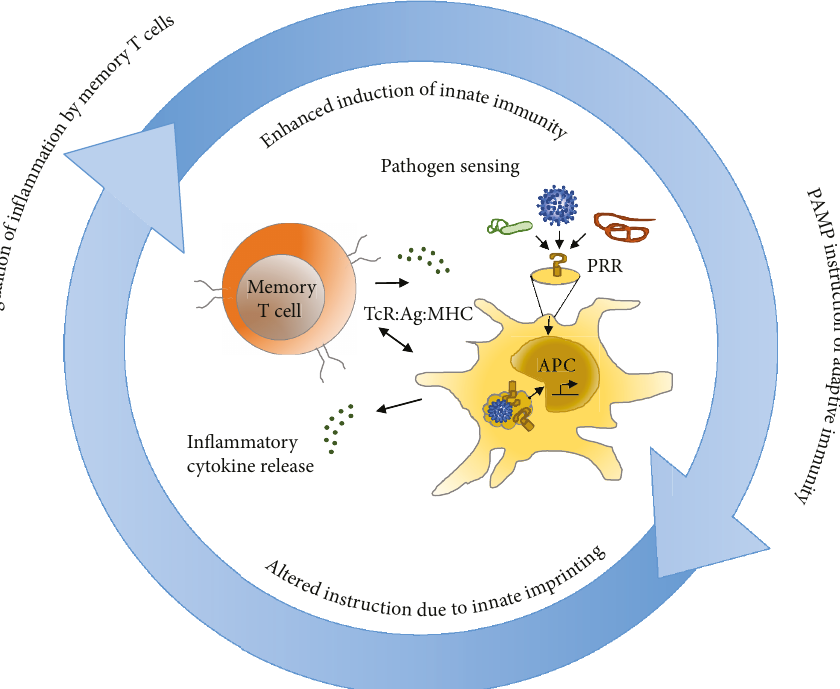
Figure 1: Memory T cells regulate in fl ammation at sites of infection. Traditional paradigms of innate instruction of adaptive immunity must now also appreciate that adaptive memory T cells regulate both the nature and shape of innate in fl ammatory responses. Memory CD4 T cell-mediated enhanced in fl ammatory responses are initiated independently of the classic PRR signaling and classic costimulatory molecule recognition and are better at containing virus than innate responses triggered in naïve hosts through PAMP-dependent